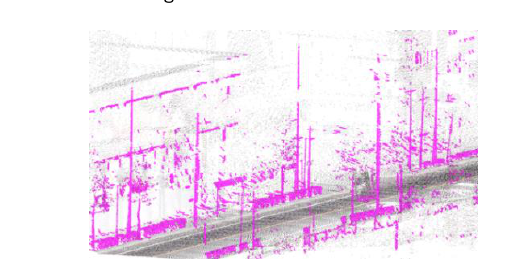
Figure 5. Patterns of scan-lines